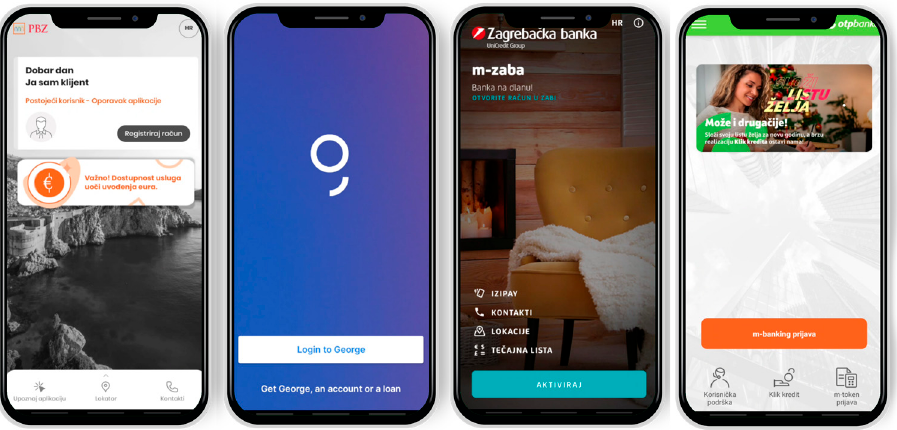
Figure 2. Login screens of evaluated mobile banking applications (from left to right: PBZ Mobile banking, Erste George, m-zaba, OTP m-banking).